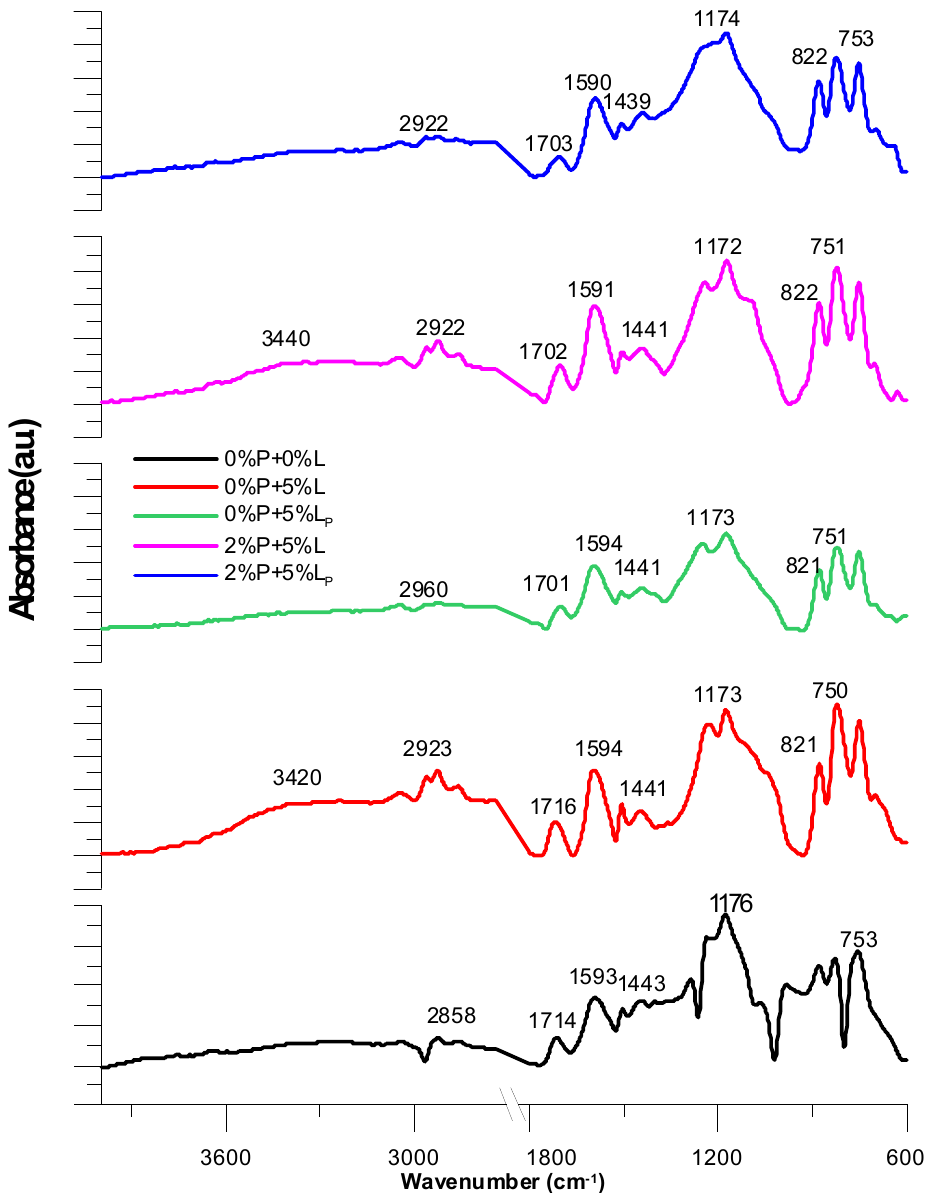
Figure 13. ATR-FTIR analysis of the composites after the flame tests.